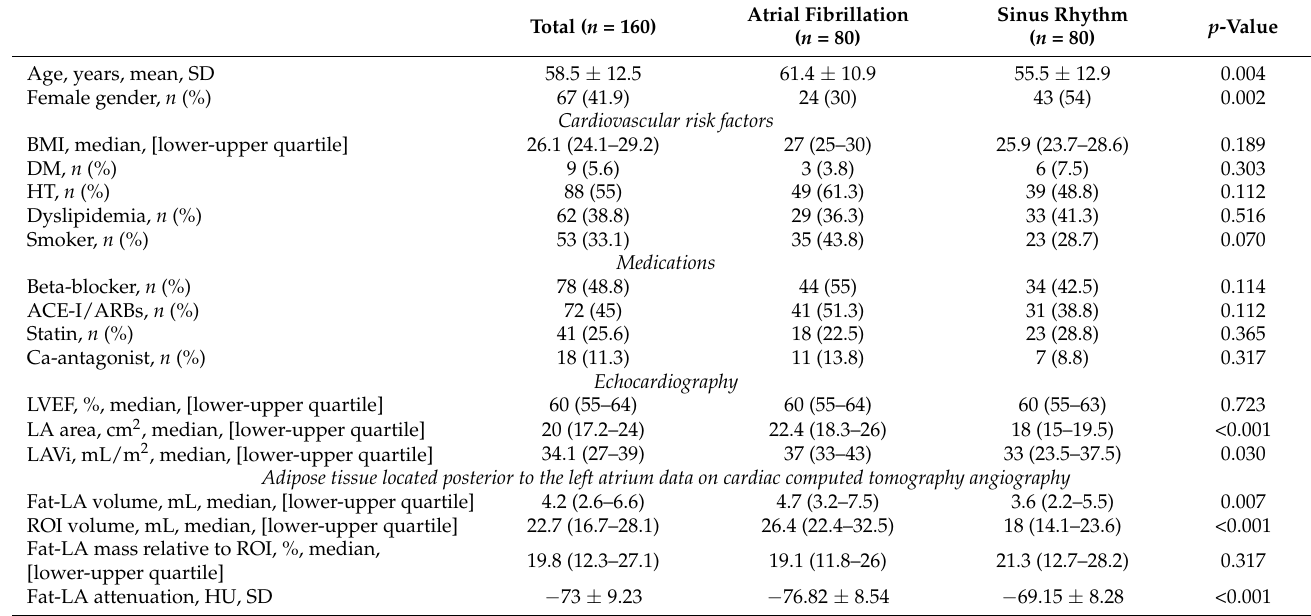
Table 1. Data of the demography, risk factors, echocardiography and adipose tissue located posterior to the left atrium.